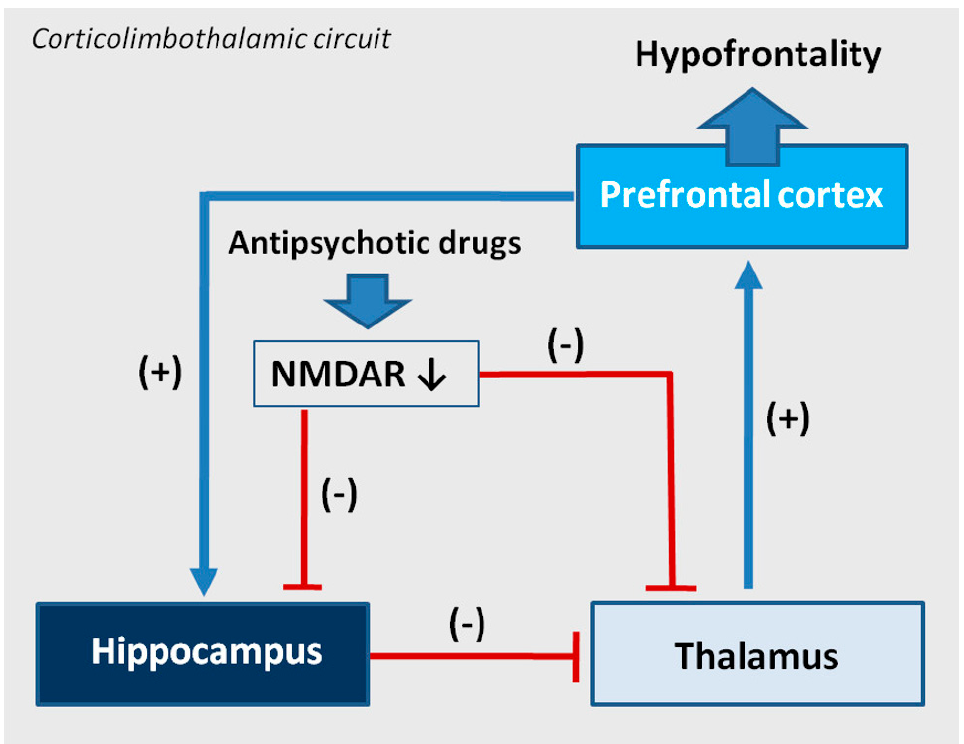
Figure 7. An effect of antipsychotics on cortical-subcortical circuits in the hypothetical drug-induced mechanism of hypofrontality. The prefrontal cortex sends excitatory glutamatergic outputs to the limbic system (hippocampal formation), its GABA—ergic inhibitory projections are running to the thalamus, from where glutamatergic innervation goes back to the cortex. Some hippocampal outputs target also ventral striatum, ventral pallidum, substantia nigra, and the ventral tegmental area (VTA). The activity of the corticolimbothalamic circuit can be disturbed due to antipsychotic drugs inducing a change of expression of NMDA receptors’ (NMDAR) subunits. A decrease of the number and activity of NMDARs can decrease the glutamatergic activity in the hippocampus and the thalamus and disinhibit glutamatergic stimulation from the thalamus to the prefrontal cortex, sustaining the hypofrontality.